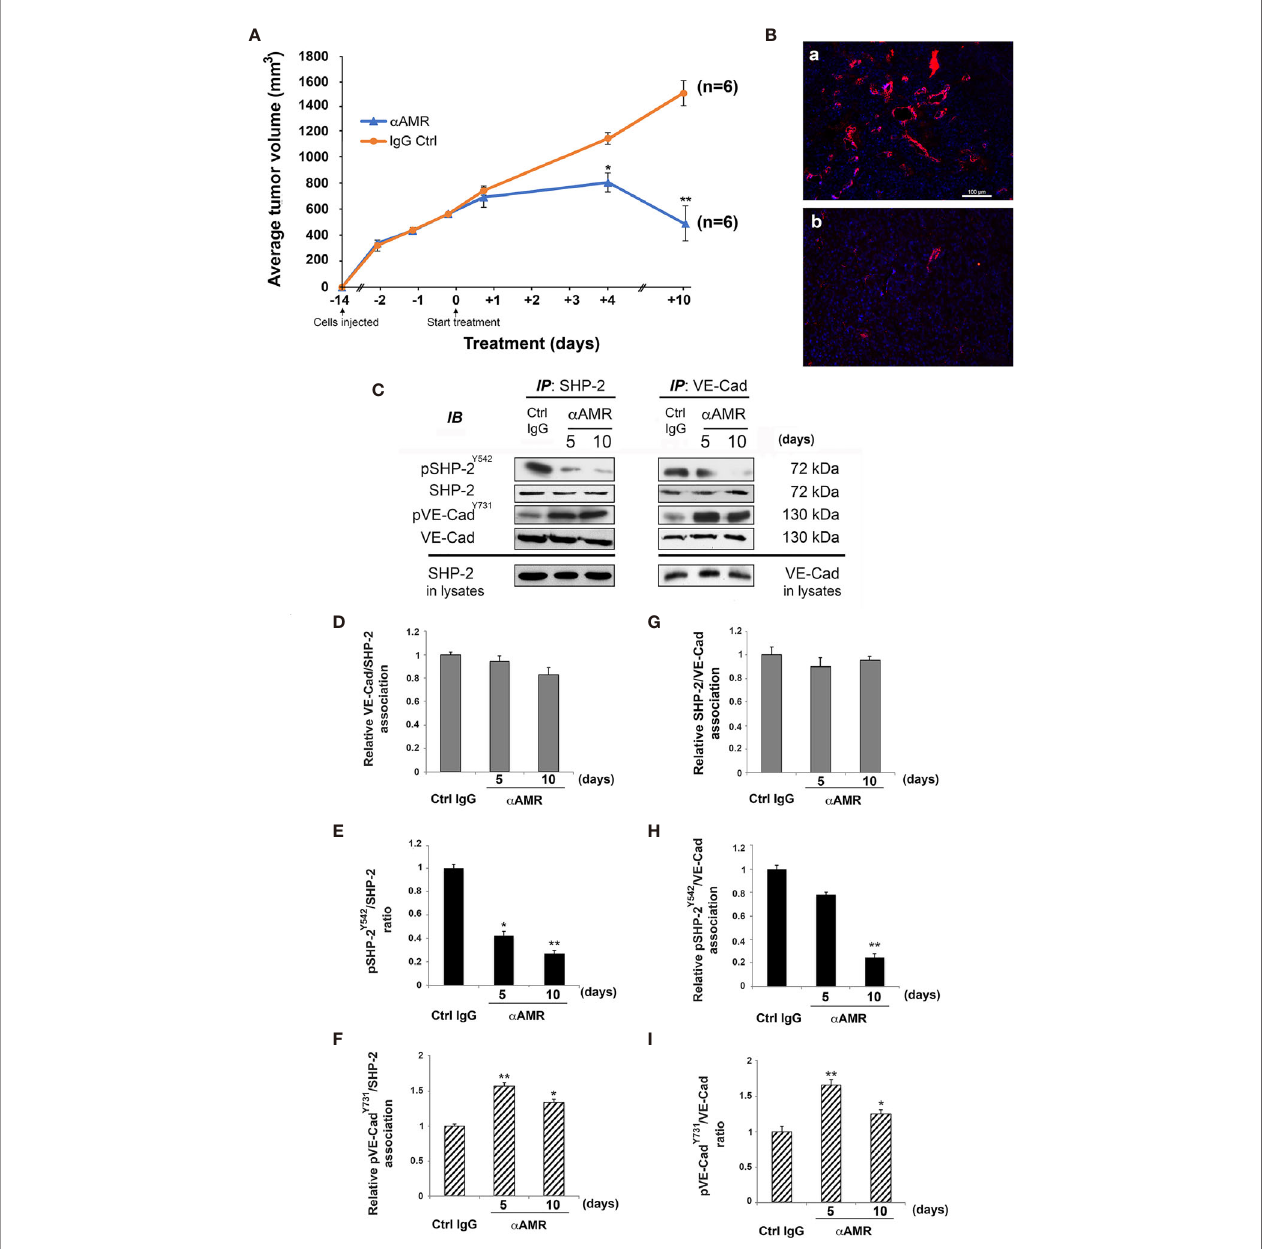
FIGURE 8 | AM blockade decreases phosphorylation for SHP-2 Y542 associated with VE-cadherin in U87 tumor xenografts. (A) Measurements of tumor volume demonstrate differences in growth of a AMR antibodies- (n = 6), and control IgG- (n = 6) treated animals during 10 days ’ time course, * p < 0.05; ** p < 0.01. (B) a AMR-treated tumors are less vascular and depleted of endothelial cells. Sections from tumor xenografts were evaluated by immuno fl uorescence for vWF (red). Tissue sections were counterstained with 4 ’ , 6-diamidino-2-phenylindole (DAPI; blue). Scale bar = 50 µm. (C) Protein extracts from a AMR-treated tumors ( a AMR) and control IgG-treated tumors (Ctrl IgG) were subjected to reciprocal immunoprecipitation for SHP-2 and VE-cadherin, followed by immunoblotting for pSHP-2 Y542 , SHP-2, pVE-cadherin Y731 , and VE-cadherin as indicated on the left. Molecular weights are indicated (right). (D) Nearly equal amounts of VE-cadherin are associated with SHP-2 independently of treatment. (E) A signi fi cant decrease for pSHP-2 Y542 after a AMR-treatment when compared to Ctrl IgG-treated tumors. (F) Signi fi cant increases for pVE-cadherin Y731 associated to SHP-2 in a AMR-treated tumors as compared to Ctrl IgG-treated tumors. (G) Nearly equal amounts of SHP-2 are associated to VE-cadherin independently of treatment. (H) A signi fi cant decrease for pSHP-2 Y542 associated with VE-cadherin subsequently to a AMR-treatment when compared to Ctrl IgG-treated tumors. (I) Signi fi cant increases for pVE-cadherin Y731 are obtained in a AMR-treated tumors when compared to Ctrl IgG-treated tumors. * p < 0.05; ** p < 0.01. Each experiment is representative of three (D – I) independent analyses of tumor samples of two independent experiments. Results are shown as means ±